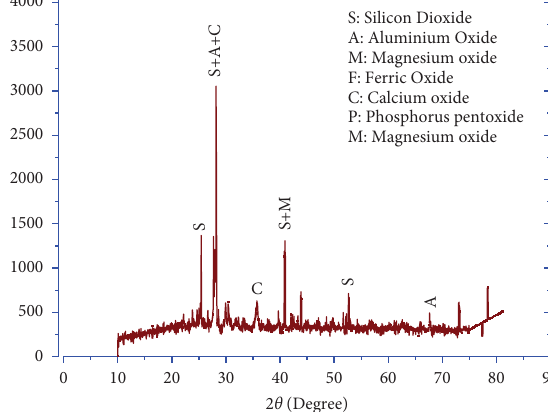
Figure 2: Chemical composition of volcanic scoria via